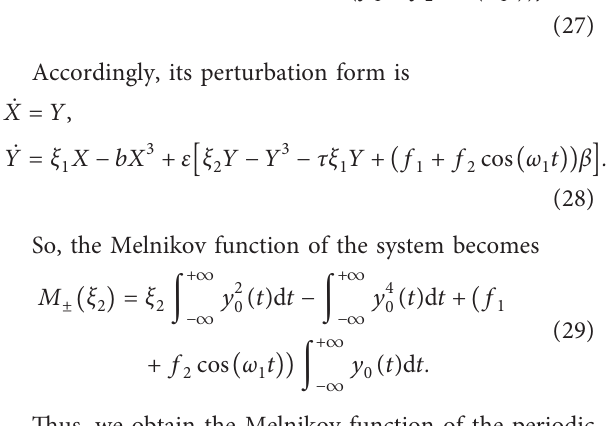
� 2 ω , 1 2 � 0 . 02 , ω � 0 . 01 , 1 2